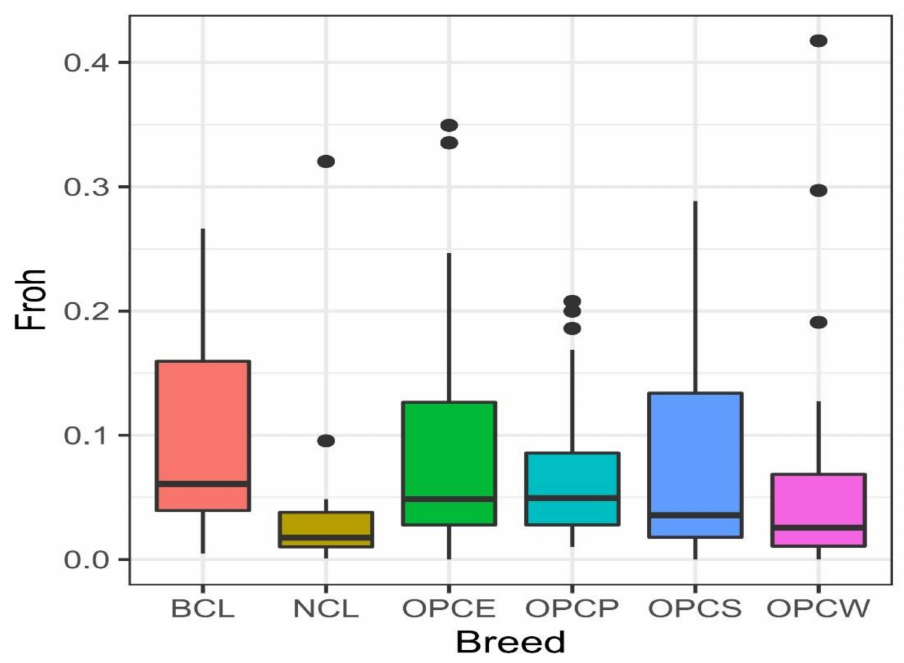
Figure 1. Distribution of runs of homozygosity inbreeding coefficients for each Colombian population. Pairwise F ST results (Figure 2), calculated on the whole dataset, were low among Colombian breeds but sufficient to differentiate between breeds. The average FST value among the six populations was 0.05. Low values of F ST were found between the OPCP with the other Caribbean hair breeds and the wool criollos from Colombia (FST~0.06 and 0.09), while the hair Creoles from the Caribbean (OPCE, OPCS, OPCW) and wool Creoles (BCL and NCL) indicated a low value of F ST (0.01 and 0.05). At a global level, the OPC